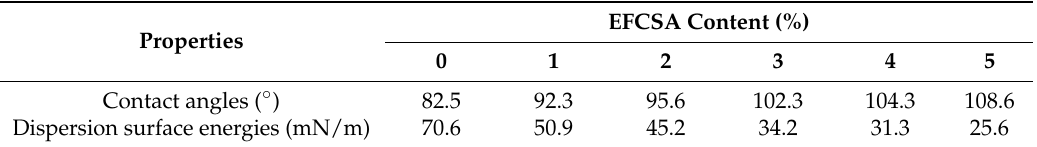
Table 5. Contact angles and dispersion surface energies of UV-cured polyurethane coatings. Coatings